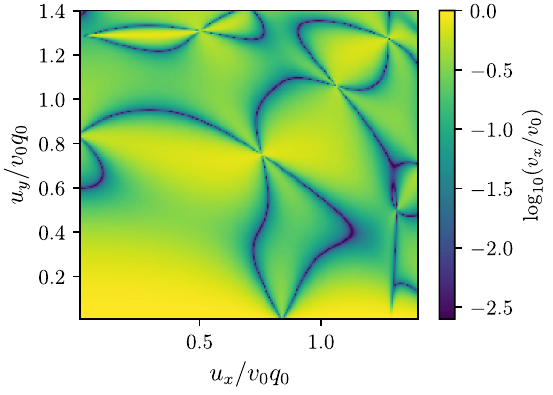
FIG. 4. The x component v of the velocity for the Dirac cone x at charge neutrality for the Hamiltonian Eqs. (13) and (16) (in logarithmic scale). One sees that v vanishes on lines in the u , x x u space, giving rise to a low-energy Hamiltonian of the form y Eq.